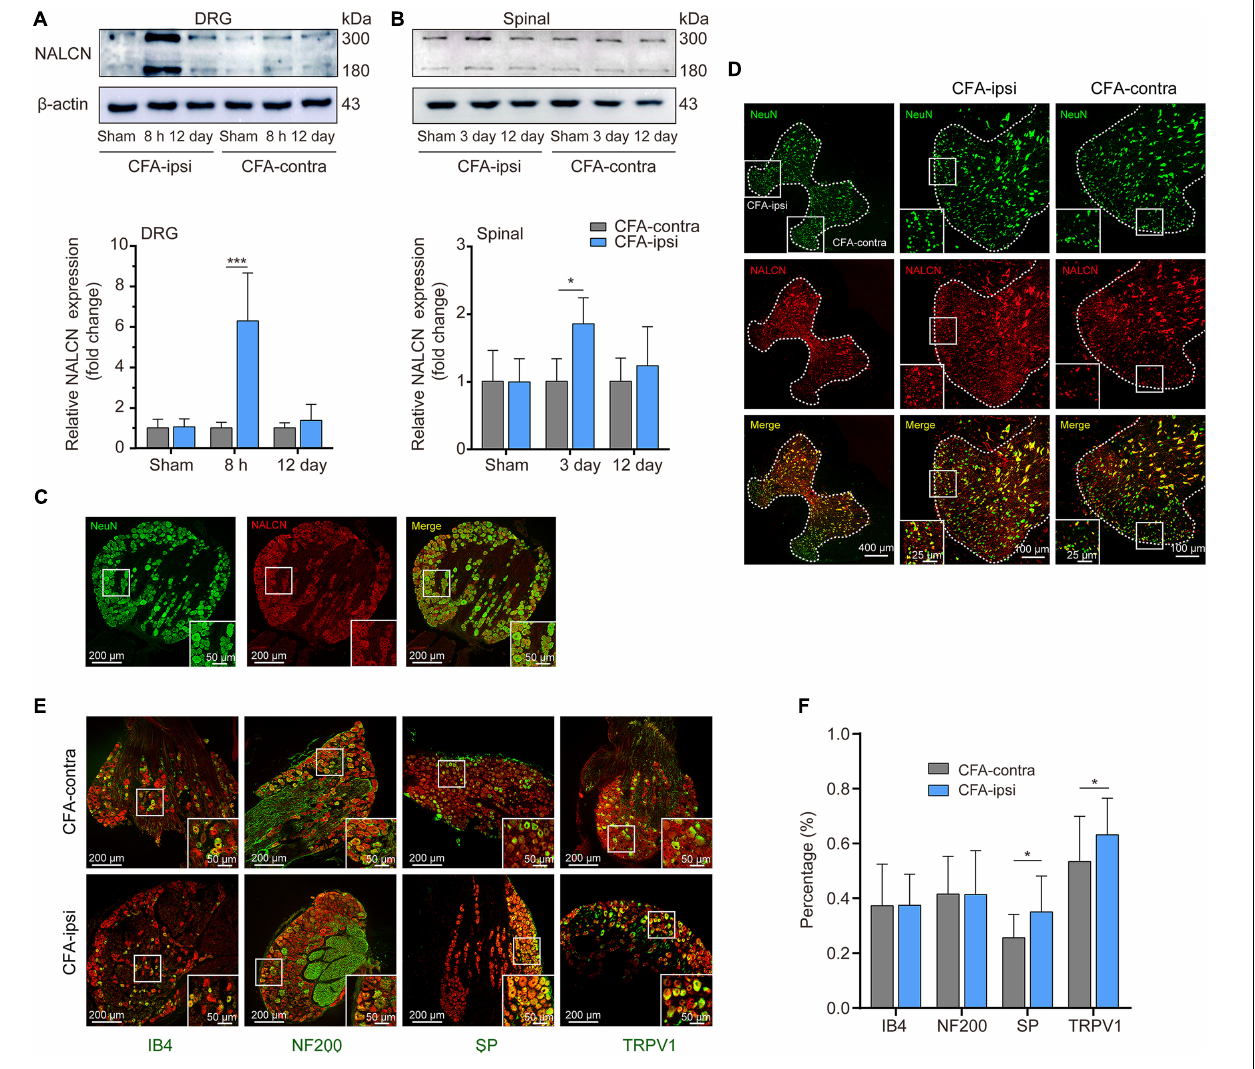
FIGURE 2 | Expression of NALCN increases in DRG and spinal dorsal horn after CFA injection in rats. (A) Representative immunoblotting image and statistical analysis indicated that the level of NALCN protein in DRG was upregulated at 8 h after CFA injection ( n = 5, by two-way ANOVA, Holm–Sidak test). (B) The level of NALCN protein in spinal cord was upregulated at day 3 after CFA injection ( n = 5, by two-way ANOVA, Holm–Sidak test). (C) Double immunofluorescence staining performed with an NALCN antibody in DRG at 8 h after CFA injection. NALCN (red) and neuronal marker NeuN (green) immunoreactivity showed NALCN mostly colocalized with NeuN. (D) Double immunofluorescence staining of spinal cord at day 3 after CFA injection showed NALCN immunoreactivity mostly colocalized with NeuN. (E) Double immunostaining shows colocalization of NALCN (red) with IB4 (green), NF200 (green), SP (green), and TRPV1 (green) in DRG neurons. (F) Percent of neuronal markers of the total population of DRG neurons. Five animals were used to obtain counts (unpaired t -test). IB4, isolectin B4; NF200, neurofilament 200 kDa; SP, substance P; TRPV1, transient receptor potential vanilloid 1. Data are presented as mean ± SD. * p < 0.05, *** p <